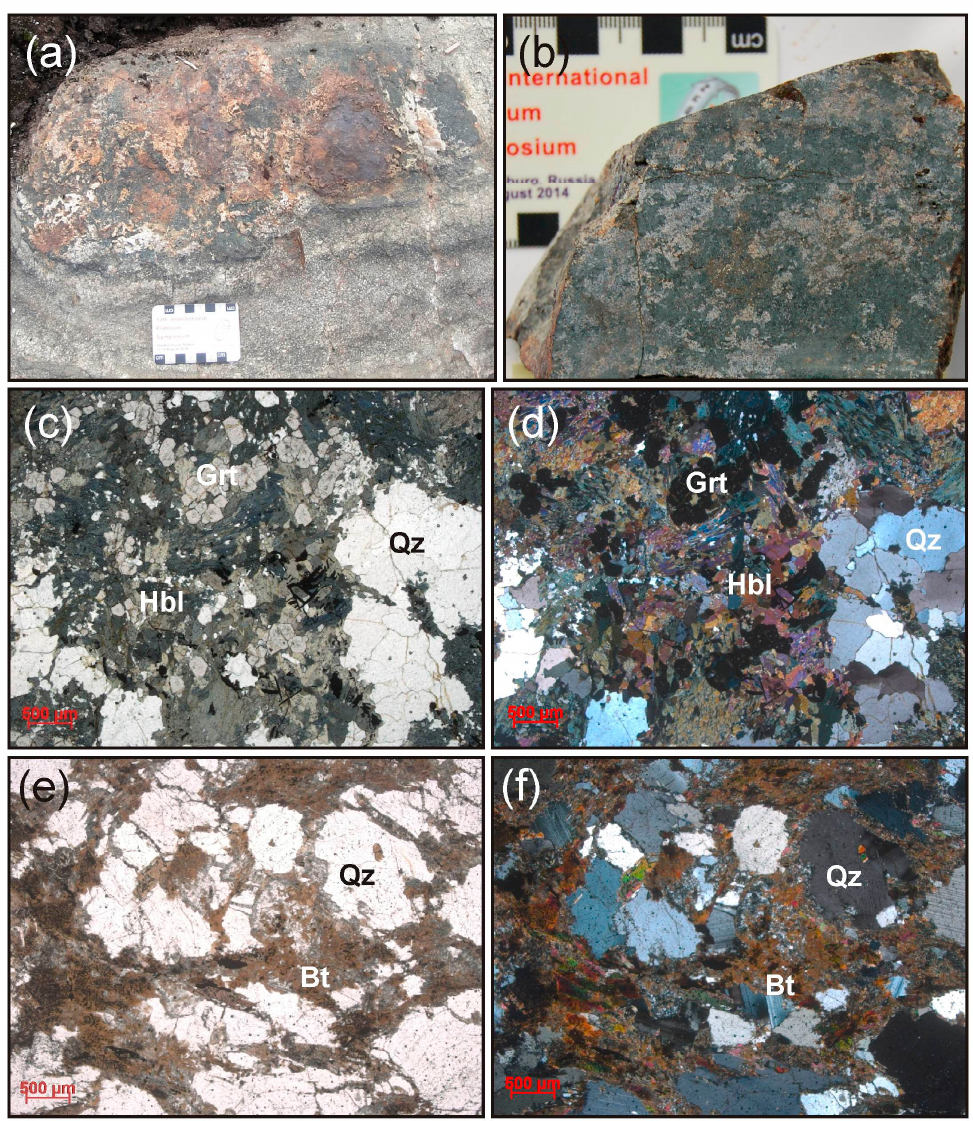
Figure 7. Boudin of garnet amphibolite with oxide mineralization: view in the outcrop ( a ), view in a sawn piece of rock ( b ), photo of transparent thin sections in plane polarized light ( c,e ), and photo of transparent thin sections in crossed polarized light ( d,f ). Grt—garnet, Hbl—hornblende, Bt—biotite, Qz—quartz. All of the rocks of the area are penetrated by plagioclase-quartz veins (Figure 3a) with northern, western, and north-western strikes. The thickness of the veins varies from 1 to 12 cm for an extension of over 5 m. Furthermore, metadolerite dikes (with a prevailing northern strike) with a thickness of several centimeters to a few meters were